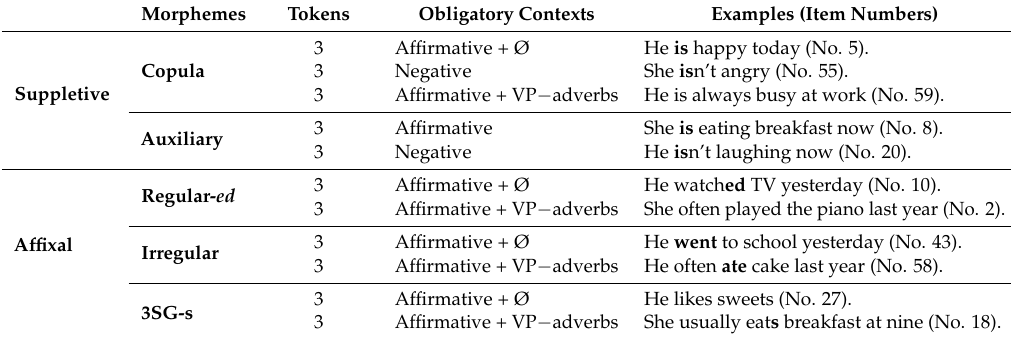
Table 6. Obligatory contexts of verbal